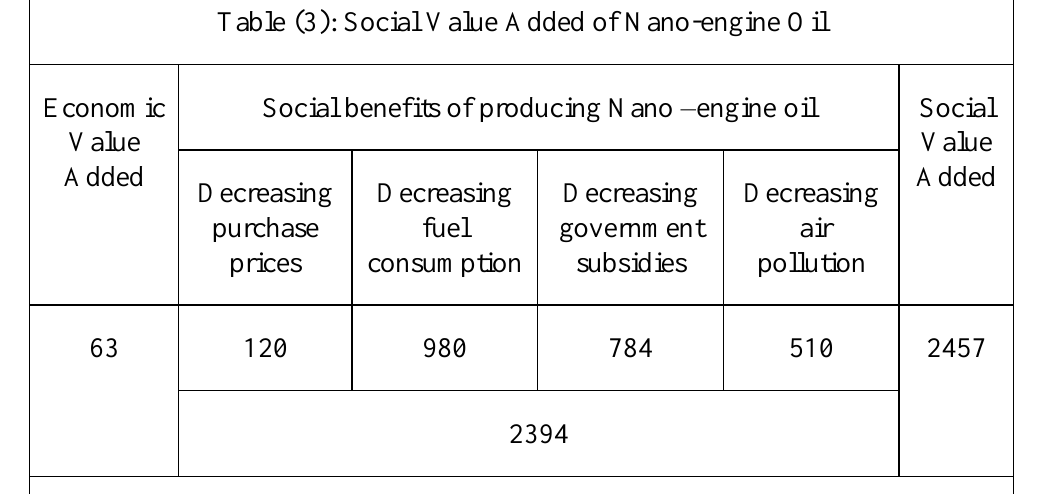
Table (3): Social Value Added of Nano-engine